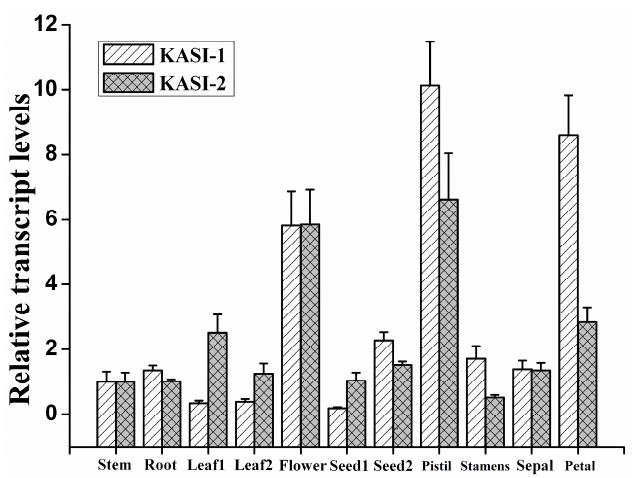
Figure 2. Relative transcript levels of tobacco KASI genes in different tissues by qRT-PCR. The relative expression was detected in root, flower, the 5th leaf at 60 DAG (leaf1), the 18th leaf at middle stage (leaf2), the seed at 6 DAF (seed1), and the seed at 12 DAF (seed2). Error bars show the standard error with five biological replicates. The expression level of stem was normalized to 1.